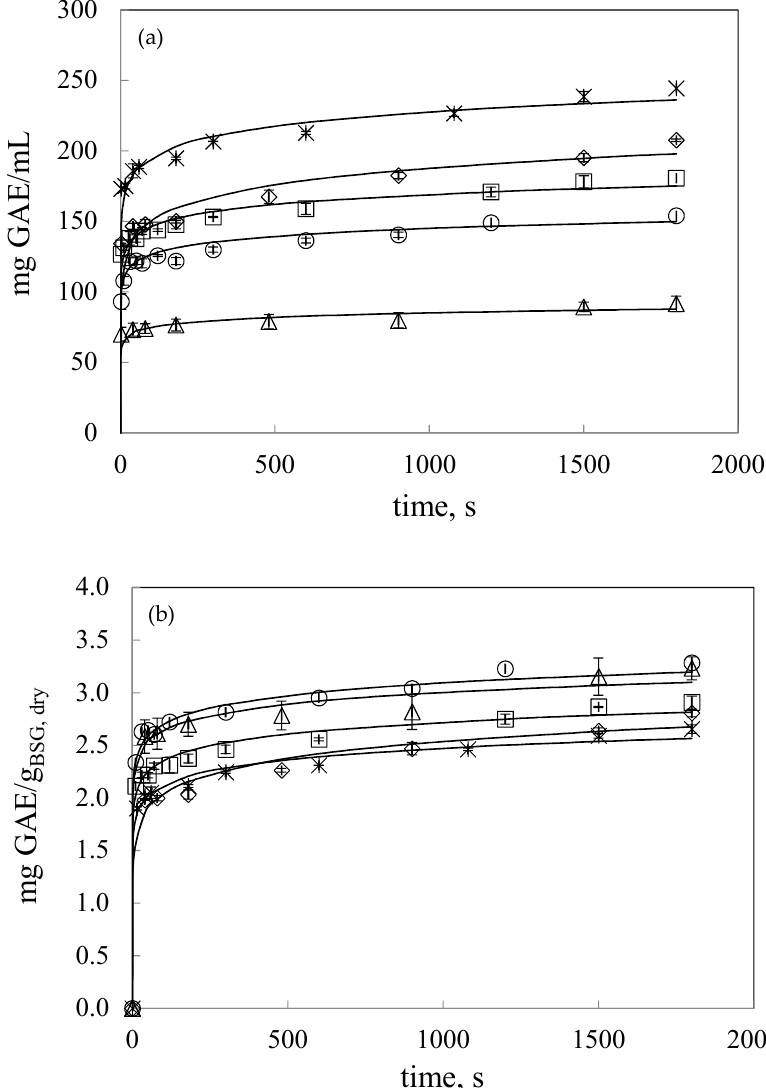
Figure 2. ( a ) Total polyphenol content in the water extracts as mg GAE / L as a function of time ( b ) Extraction yield, mg GAE / g BSG,dry for UAE at 47 ◦ C, at di ff erent solvent:mass ratios (mL:g BSG,dry ) as a function of time: × 10.9; ♦ 13.6; (cid:3) 18.1; 21.7; (cid:52) 35.3. Continuous lines represent the Weibull model. (cid:35)